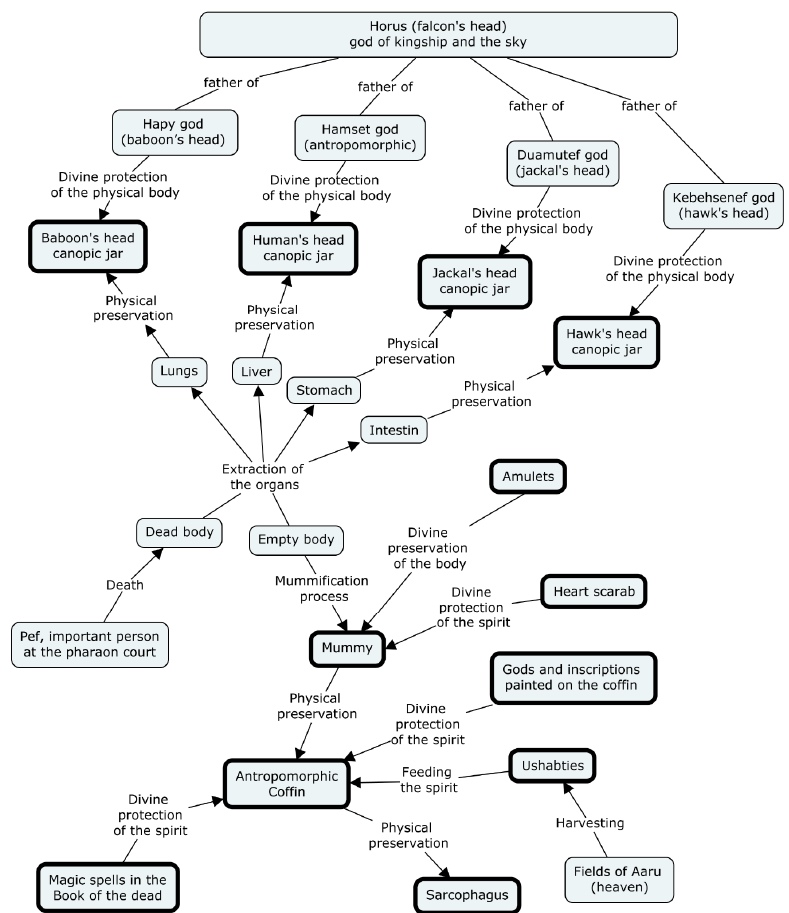
Figure 4. The graph connecting some of the actual objects in the exhibit (thick border), intangible heritage or no-longer extant objects (thin border) and the intangible heritage relations (connecting clauses). The Book of the Dead and the decorations over the coffin are linked with all the other items, but the connections are not represented for the sake of graphical clarity. To overcome these problems, the navigation mapping was re-designed, synthetizing the correct understanding provided by curators. In addition, an appropriate communication strategy was developed to ensure the correct use of the digital media as, for example, dedicated graphic icons, specific colors associated with the different themes and simplified interactions with 3D content. Hence, the application has been divided into four levels, with an increasing depth of analysis and interaction modalities (Figure 5).